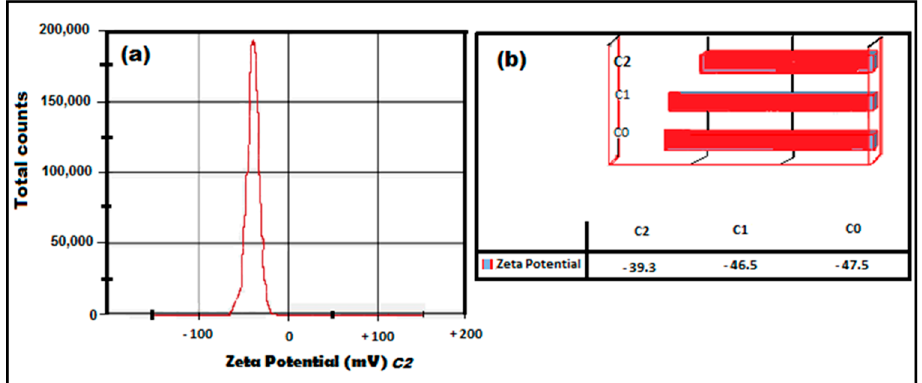
Figure 10. Zeta potential (mV) for curcumin concentrations ( a ) apparent zeta potential for C2 ( b ) zeta potential for C2, C1, and C0 concentrations. Table 1. Characteristics of C-Ag NPs synthesized from the curcumin samples C2, C1, and C0.